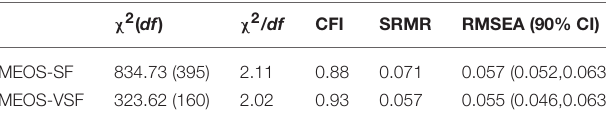
TABLE 6 | CFA model